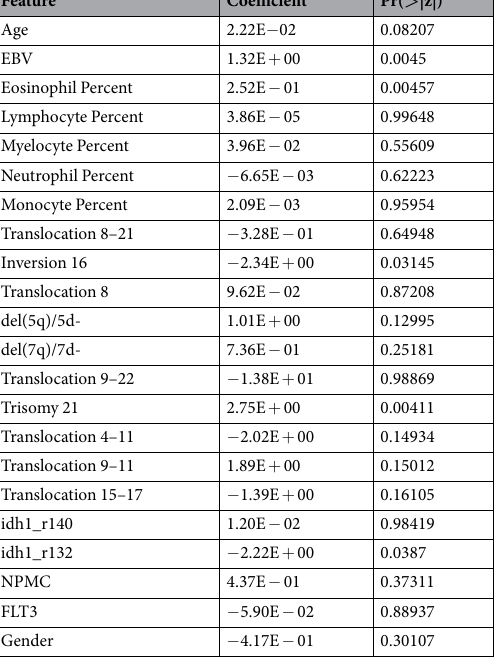
Table 2. Multivariable Cox regression for AML samples. The coefficient represents the impact of features. Pr( > |z|) defines the statistical significance. |z| is the absolute value of the Wald statistics. It represents if the feature coefficient is statistically different from zero. Each translocation is from a chromosome to another, for example Translocation 8–21 is a translocation between chromosomes 8 and 21. The cytogenetic deletion on various sites and sizes on chromosome 7, and 5 are represented by del. Mutations on the IDH1 gene on arginine amino acid (r) on various sites (132,140) observed in adult AML tumors. FLT3 mutation are consistently observed in forms of insertion, deletions and missense and intronic variants and reported as part of patient clinical